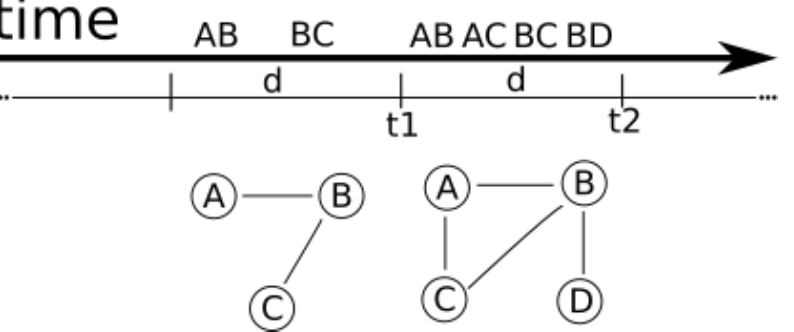
Figure 1. A small example to showcase how the dynamic User Interaction Temporal Graph (d-UITG) is